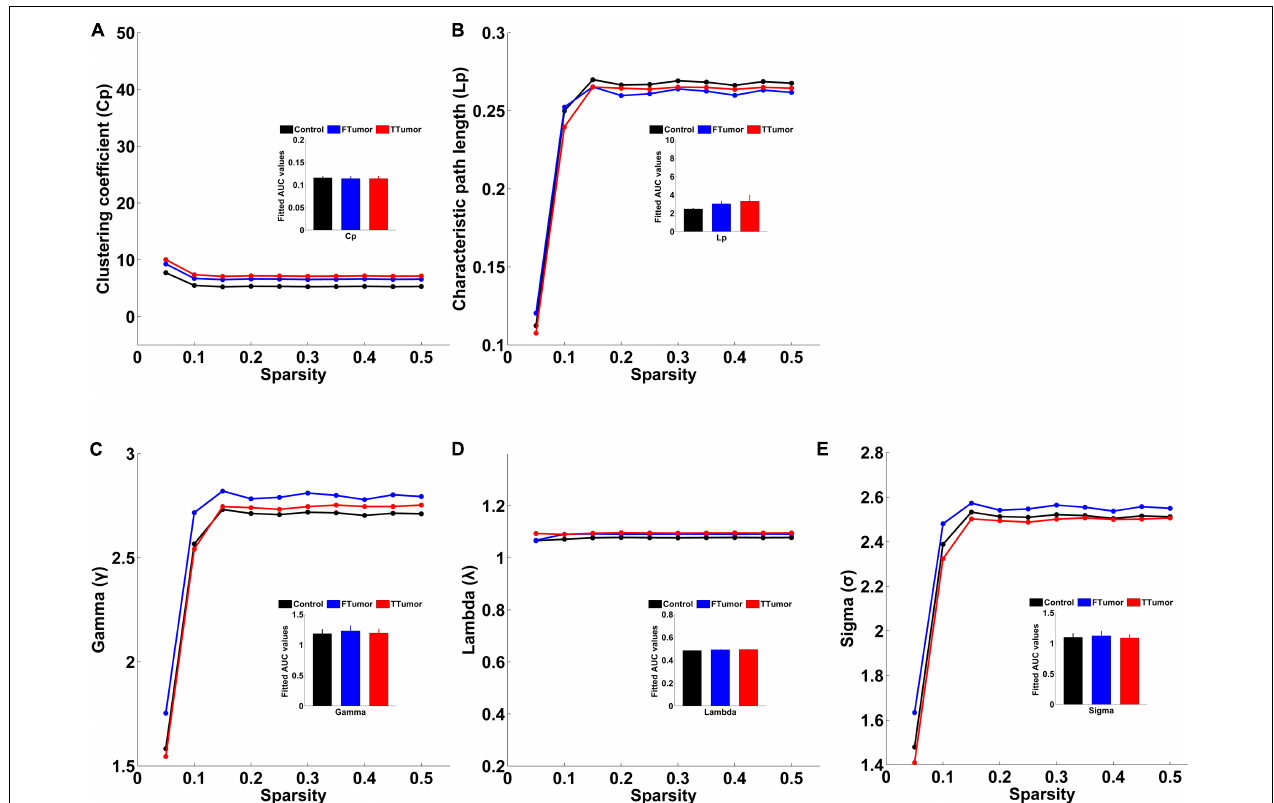
FIGURE 3 | Small-world property parameters of WM structural networks across the sparsity among the control, FTumors, and TTumors. FTumors, frontal tumors; TTumors, temporal tumors; WM, white matter. (A) indicating comparison of clustering coefficient parameter among three groups; (B) indicating comparison of characteristic path length parameter among three groups; (C) indicating comparison of gamma parameter among three groups; (D) indicating comparison of lambda parameter among three groups; (E) indicating comparison of sigma parameter among three groups.